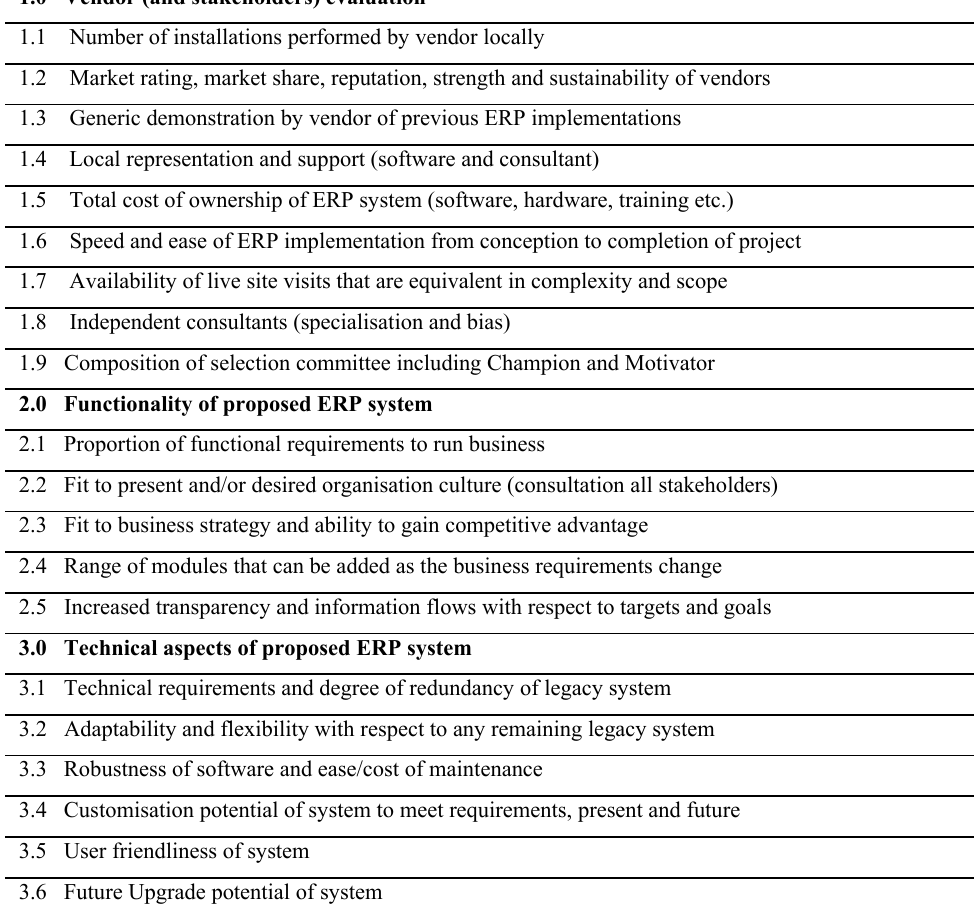
Table 1: Benchmark selection criteria